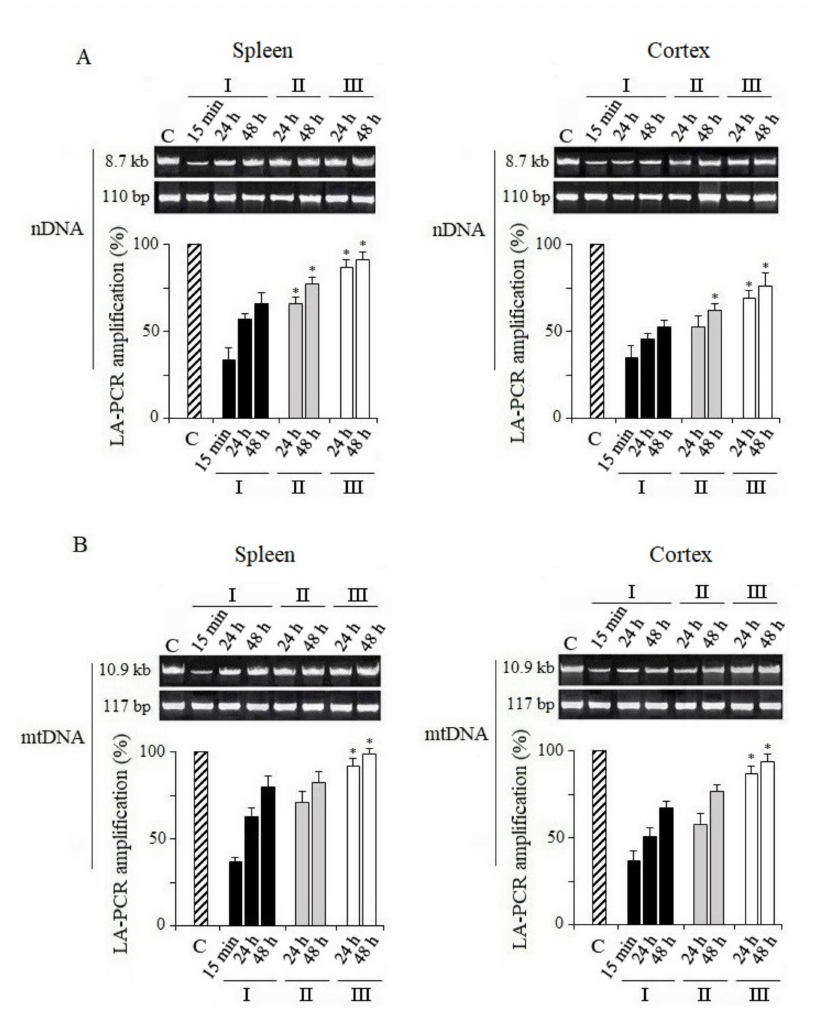
Figure 1. Analysis of damage and repair of nuclear DNA and recovery of mitochondrial DNA. Long fragments of nDNA (8.7 kb) and mtDNA (10.9 kb) were measured. These data were normalized by the measured levels of the short fragment of nDNA (110 bp) and mtDNA (117 bp), obtained using the same DNA sample. ( A ) Quantitative analysis of the LA-QPCR amplicons of nDNA extracted from spleen and cerebral cortex. ( B ) Quantitative analysis of the LA-QPCR amplicons of mtDNA extracted from spleen and cerebral cortex. Data are presented in % to control (C). Here and in other figures: the dose of X-ray irradiation of mice was 5 Gy and MEL was administered to mice before and after irradiation as a single dose of 125 mg/kg. Electropherogram samples of synthesized amplicons are presented above the histograms. The numbers (15 min, 24 h, 48 h) above and below indicate the time after irradiation. I—mice without MEL administration; II—MEL administration before irradiation; III—MEL administration after irradiation. The data are presented as mean ± SEM of 5–6 independent experiments. Statistical significance was set at * p <